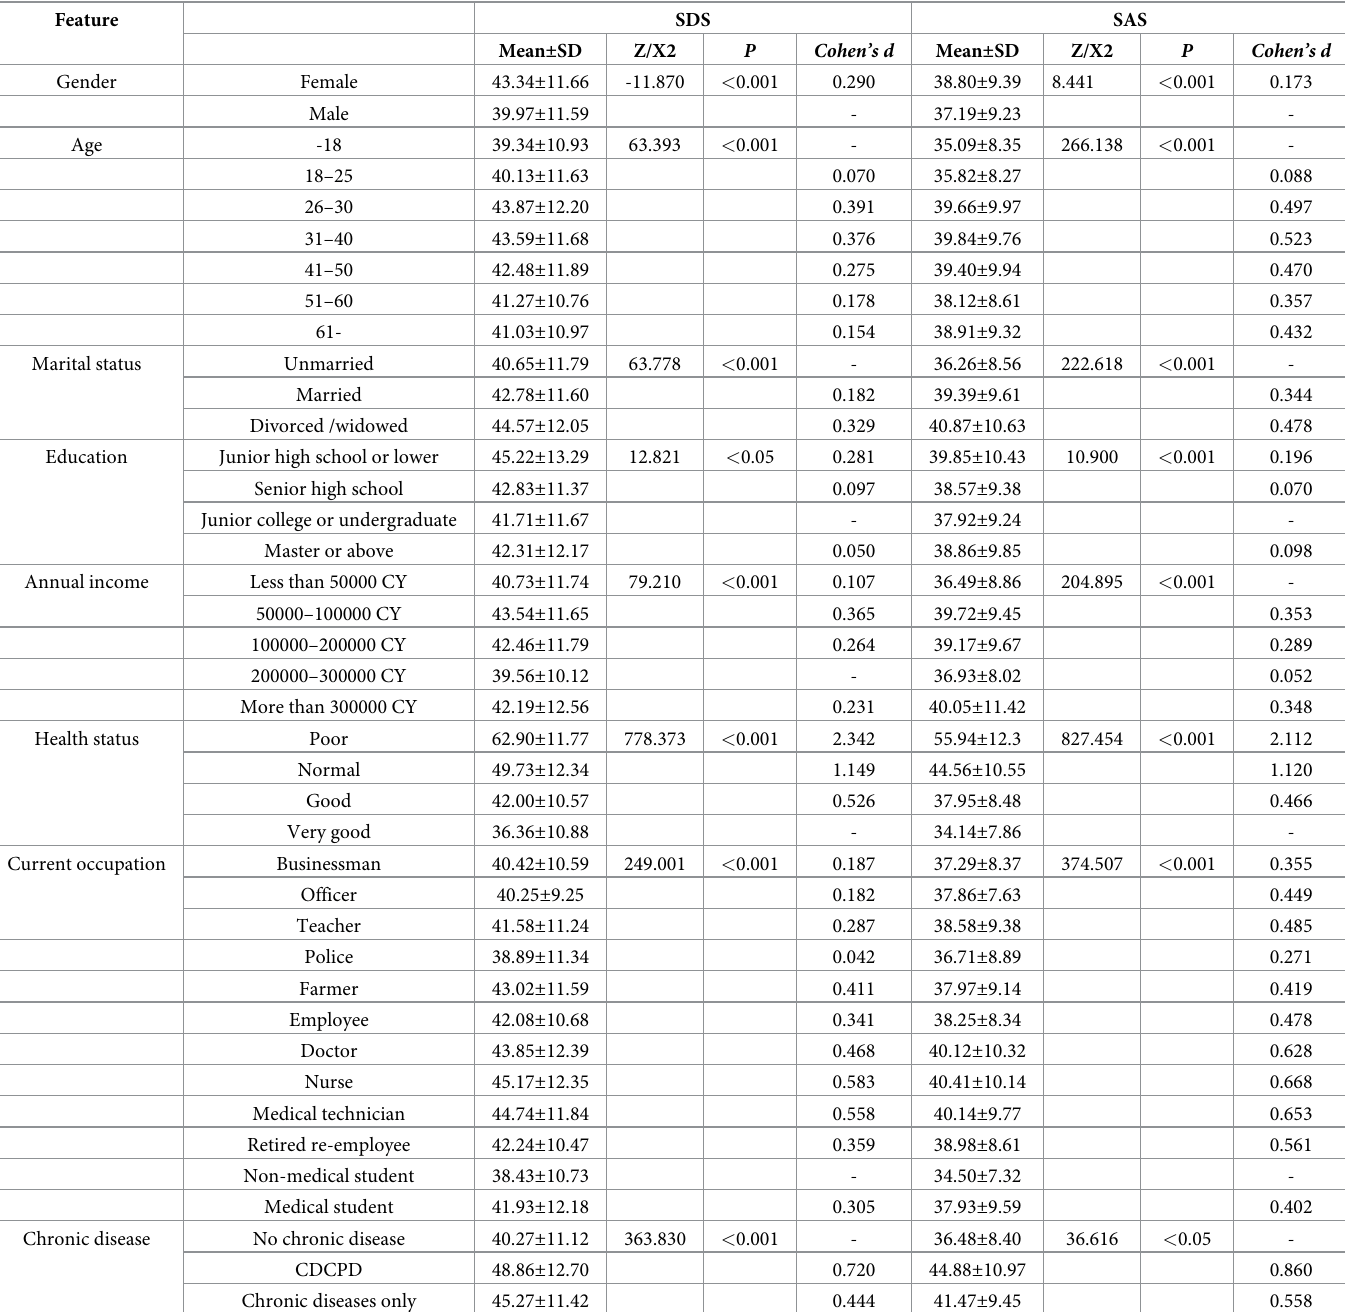
Table 4. Scores of depression and anxiety in participants with different sociodemographic backgrounds during the COVID-19 pandemic (N = 5854).